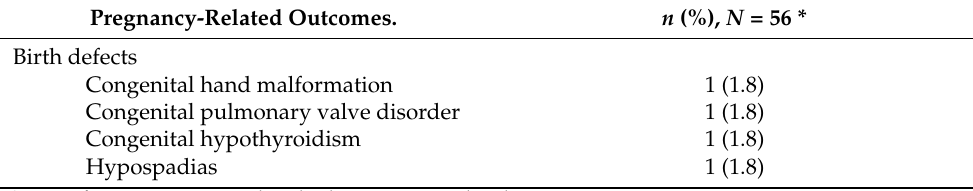
Table 2. Cont. Pregnancy-Related Outcomes.